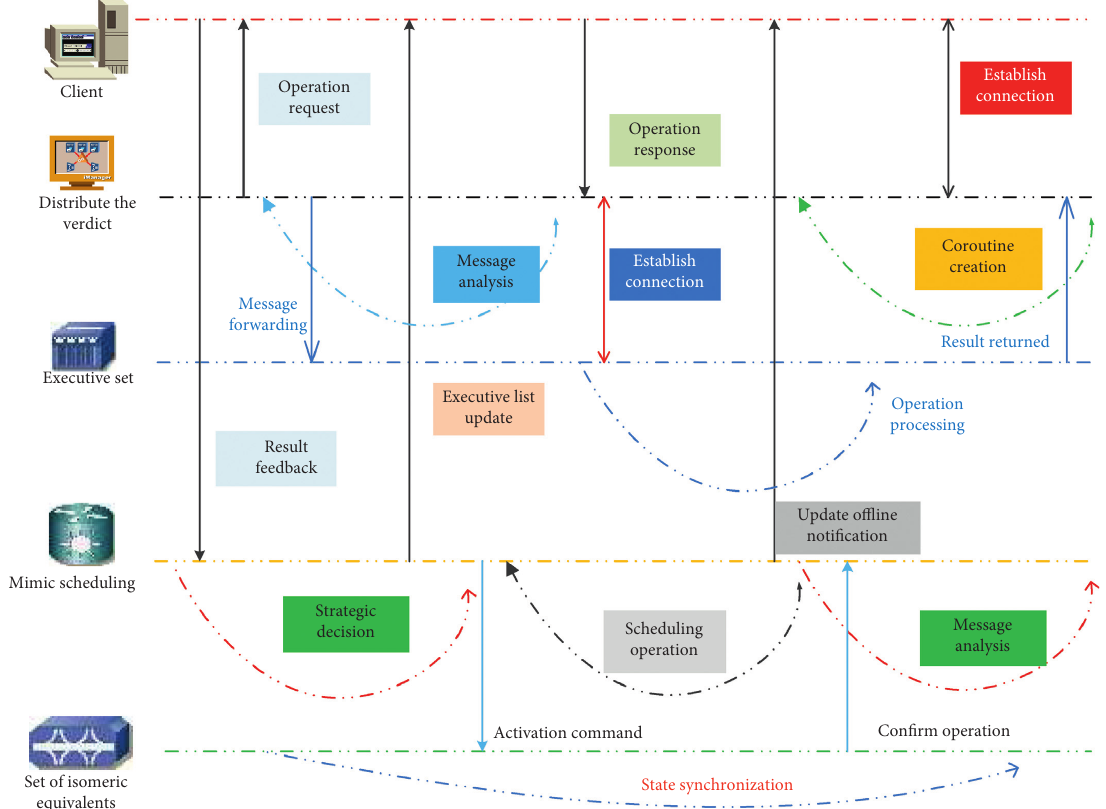
Figure 3: Schematic diagram of distributed storage information